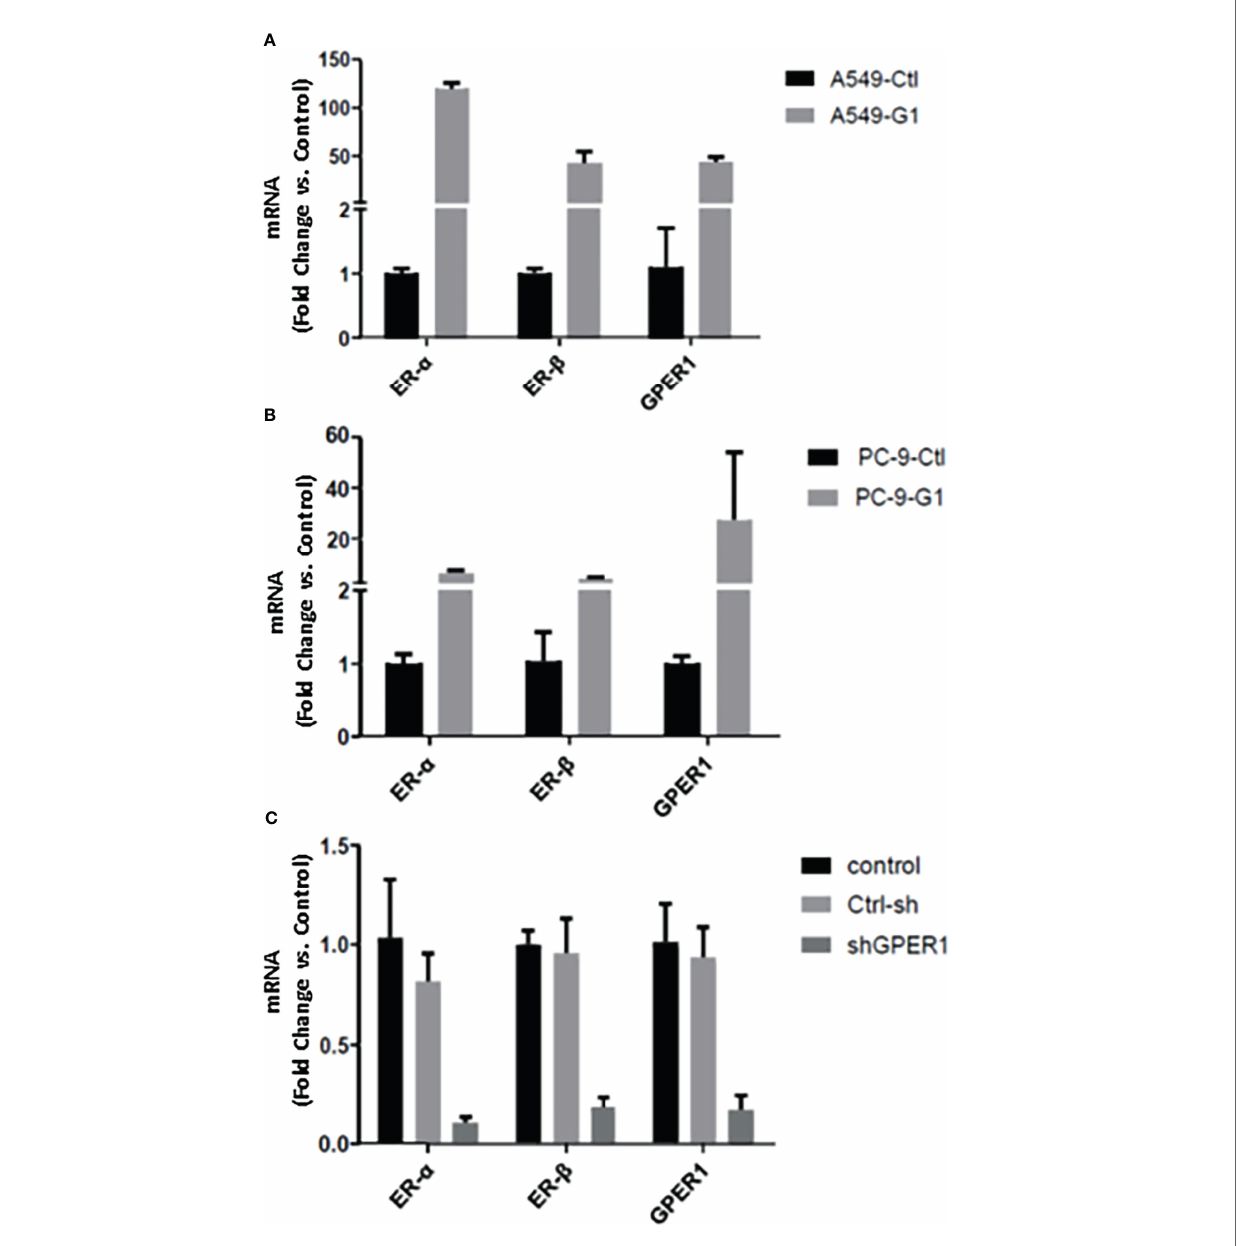
FIGURE 5 | GPER1 regulated the expression of ER a and ER b at mRNA level. The change of GPER1 was more drastically in A549 (50 folds) (A) than that in PC-9 cells (B) (25 folds) in response to G1. likewise, knockdown of GPER1 downregulated the expression of both ERa and ERb in A549 cells (C)